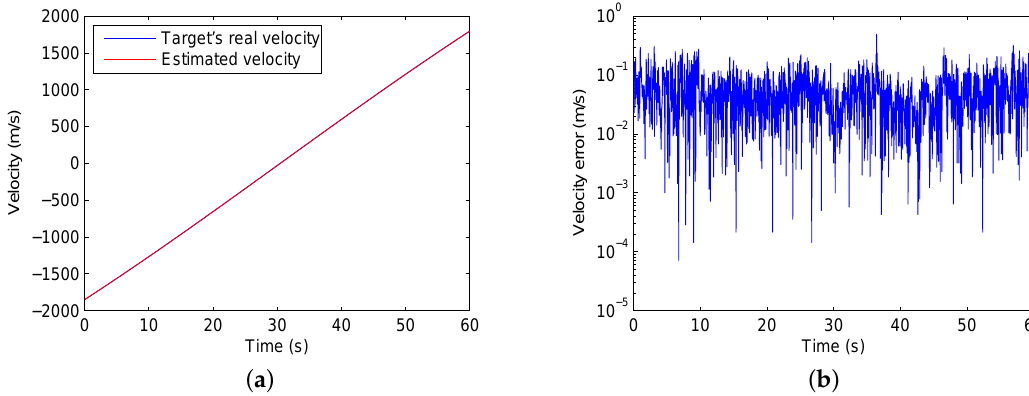
Figure 10. Estimation results of Dataset 1. ( a ) The estimated velocity and the target’s real velocity (due to the high speed of the target and the high precision of the estimated velocity, the two lines overlap). ( b ) The absolute values of differences between the estimated velocities and the target’s real velocities.